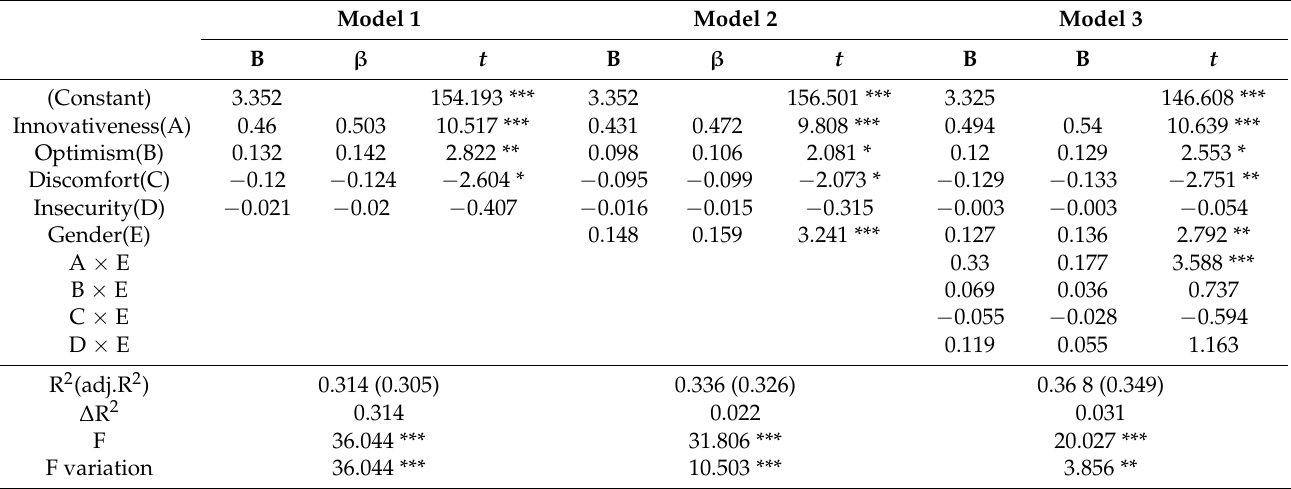
Table 5. Results of the hierarchical regression analysis.